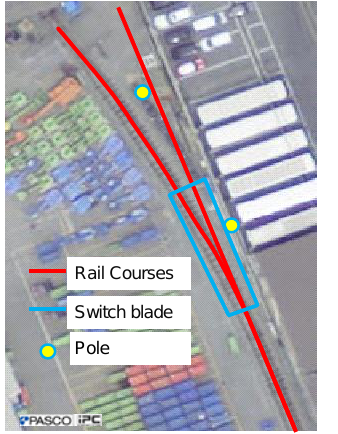
Figure 3. Overview of test rail of the site